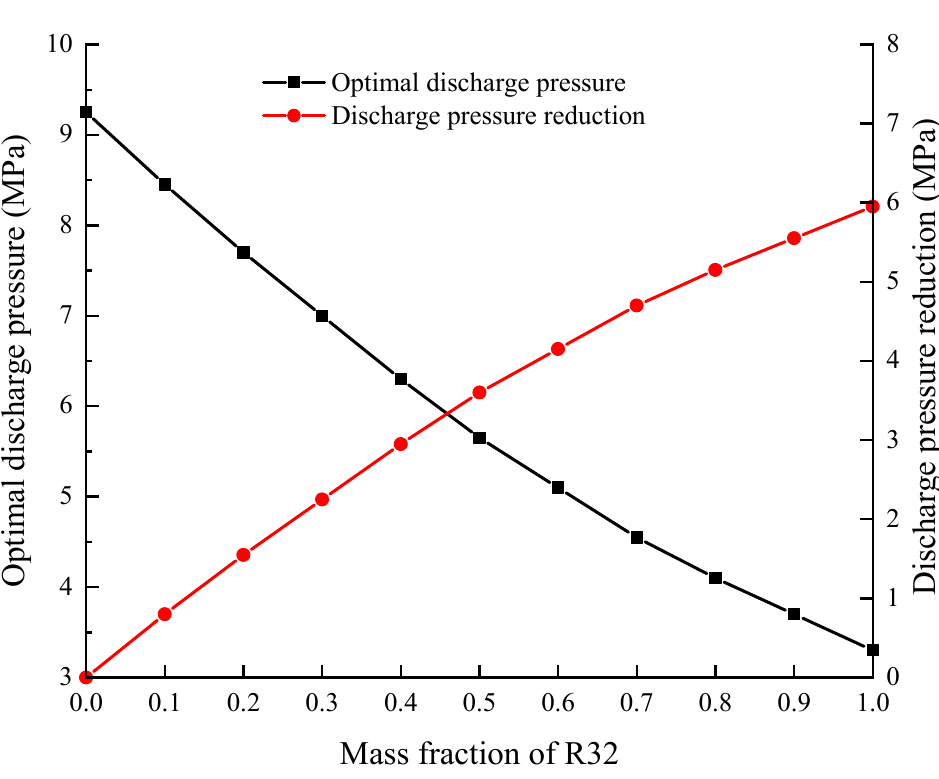
Figure 5. Optimal discharge pressure and pressure reduction across the R32 mass fraction range.